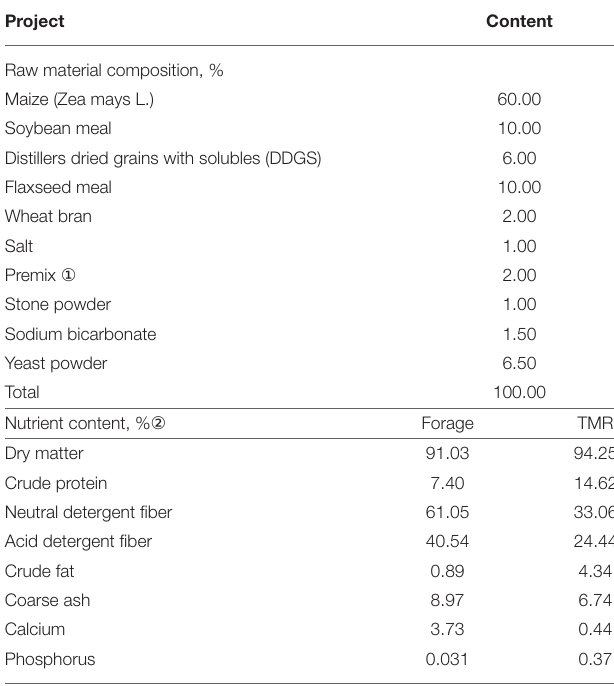
TABLE 1 | Composition and nutrient levels of diets (DM